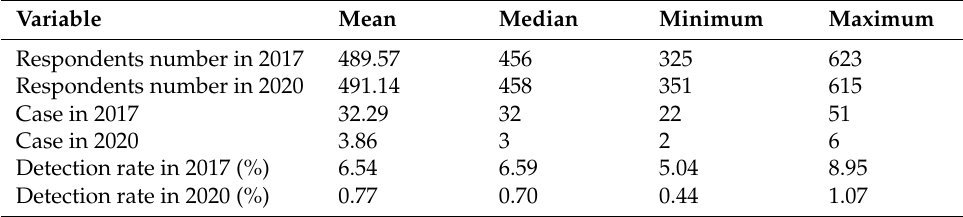
Table 2. Descriptive statistics for key